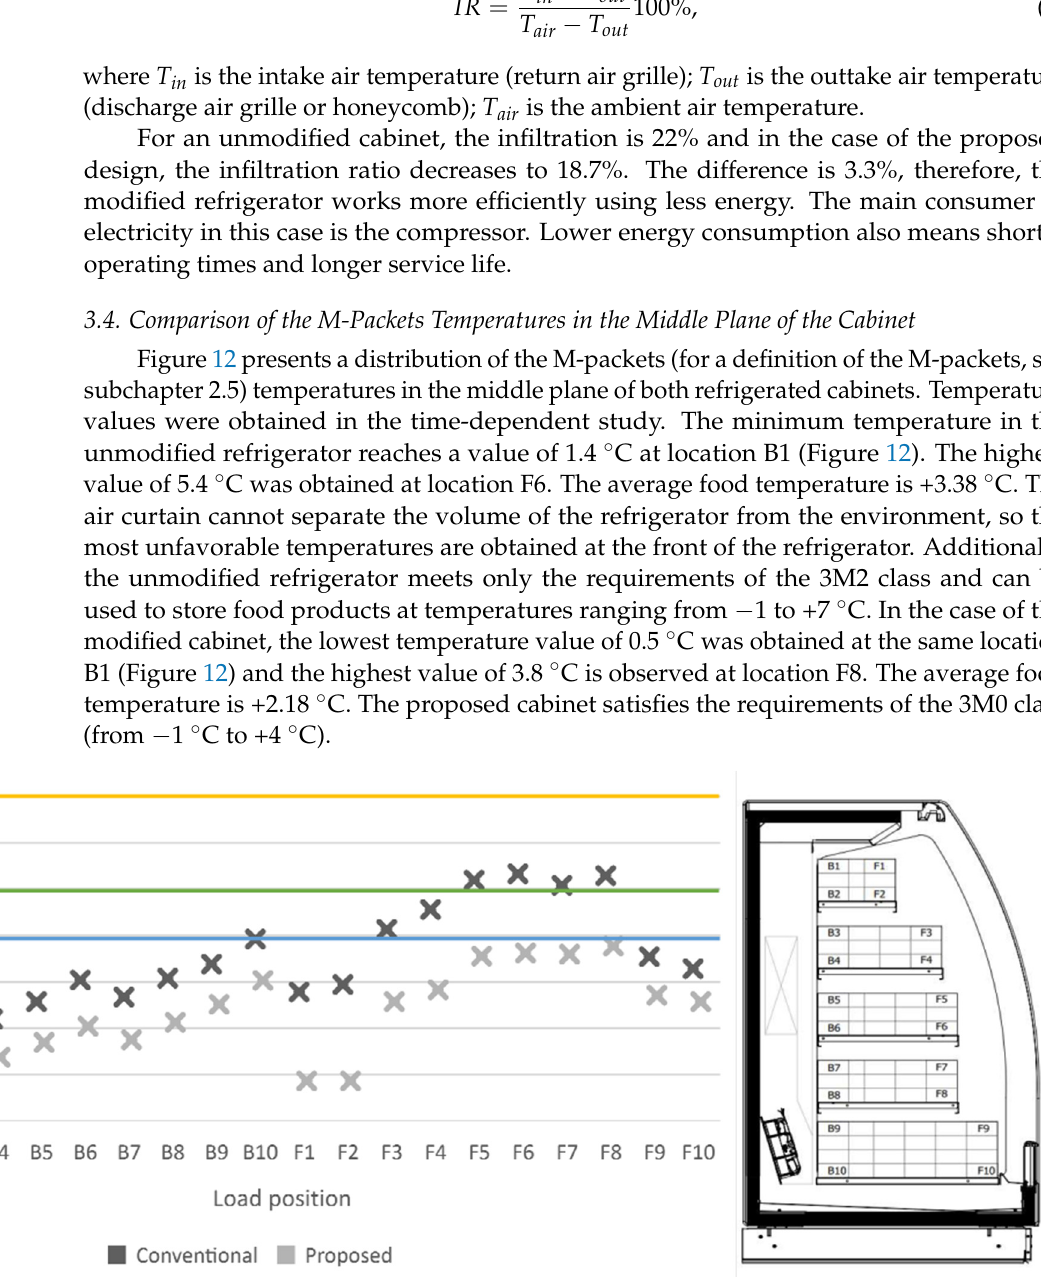
Figure 12. Distribution of the temperature of food products in the middle plane of refrigerated cab- inets.